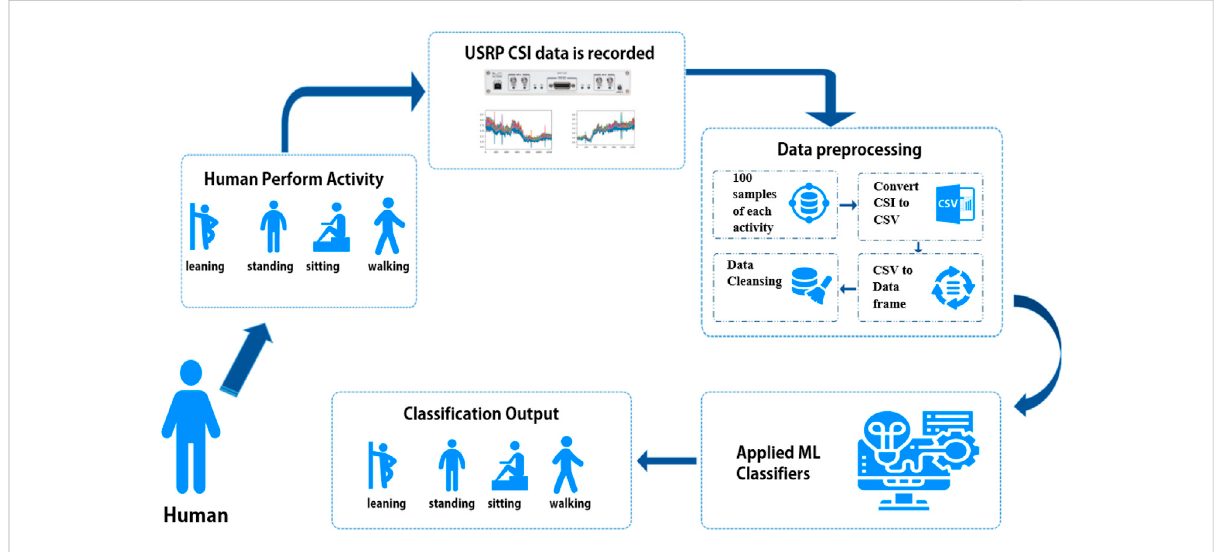
FIGURE 12 Block diagram demonstrating non-invasive indoor human activity detection for smart home applications using software-de fi ned radios (Khan et al.,